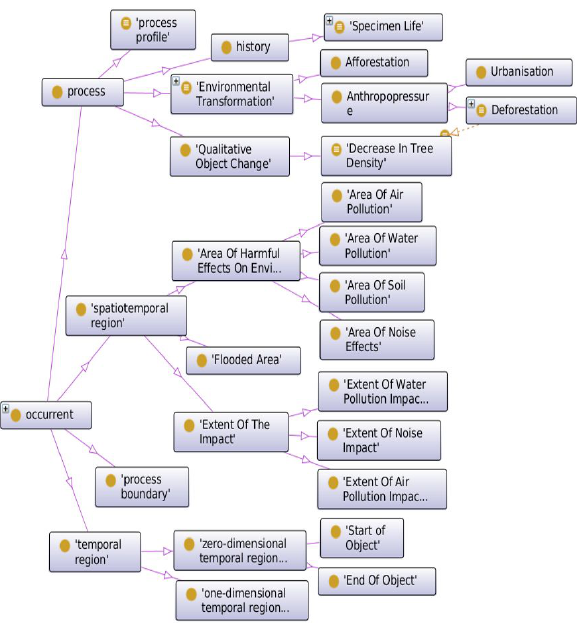
Figure 7. Extending BFO occurent classes by classes representing processes and events in spatial management